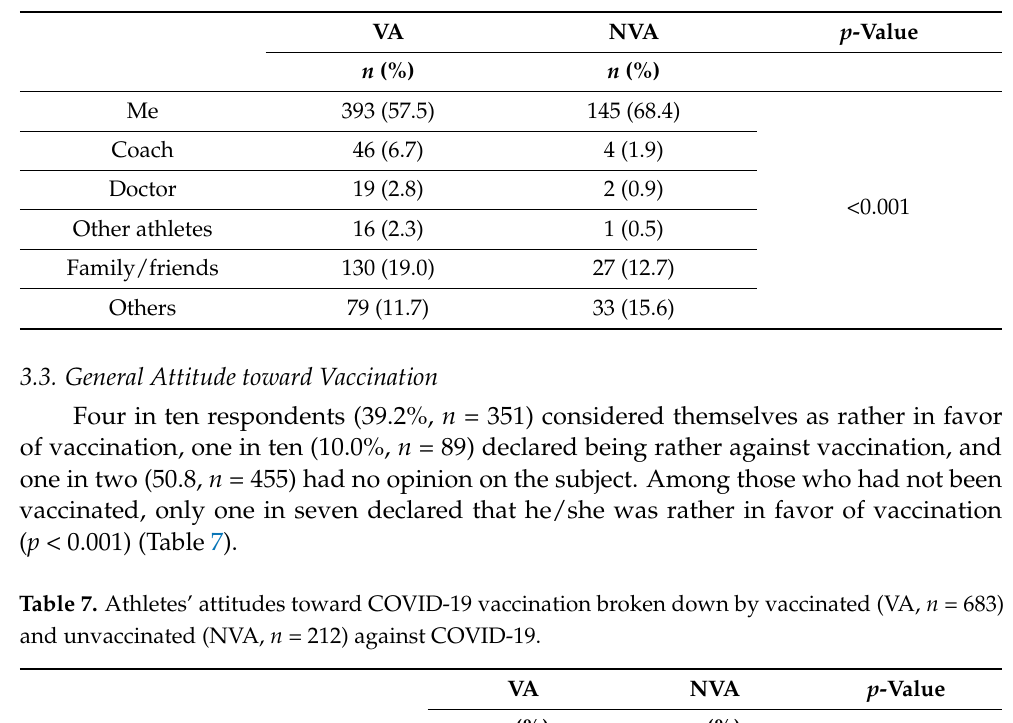
Table 6. Who had the greatest influence on your decision to get vaccinated or not against COVID-19? Responses broken down by vaccinated (VA, n = 683) and unvaccinated (NVA, n = 212) against COVID-19.